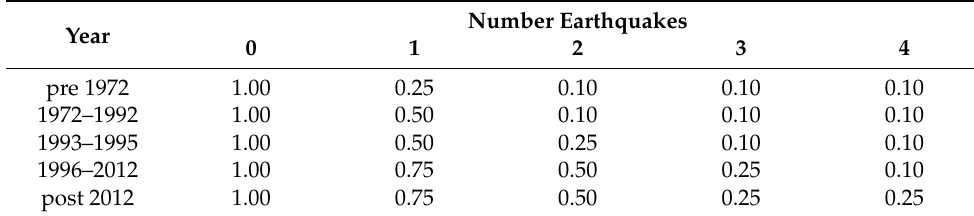
Table 6. Factor B for reinforced concrete